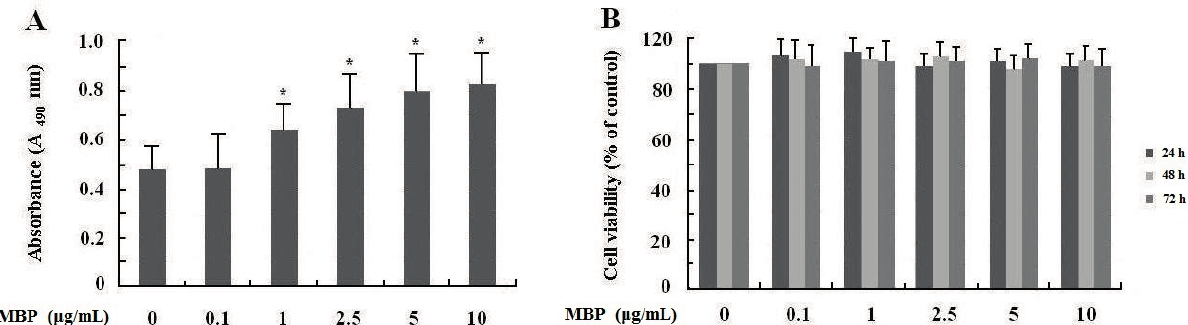
Figure 2. Effects of MBP on pinocytosis and viability of RAW264.7 macrophage